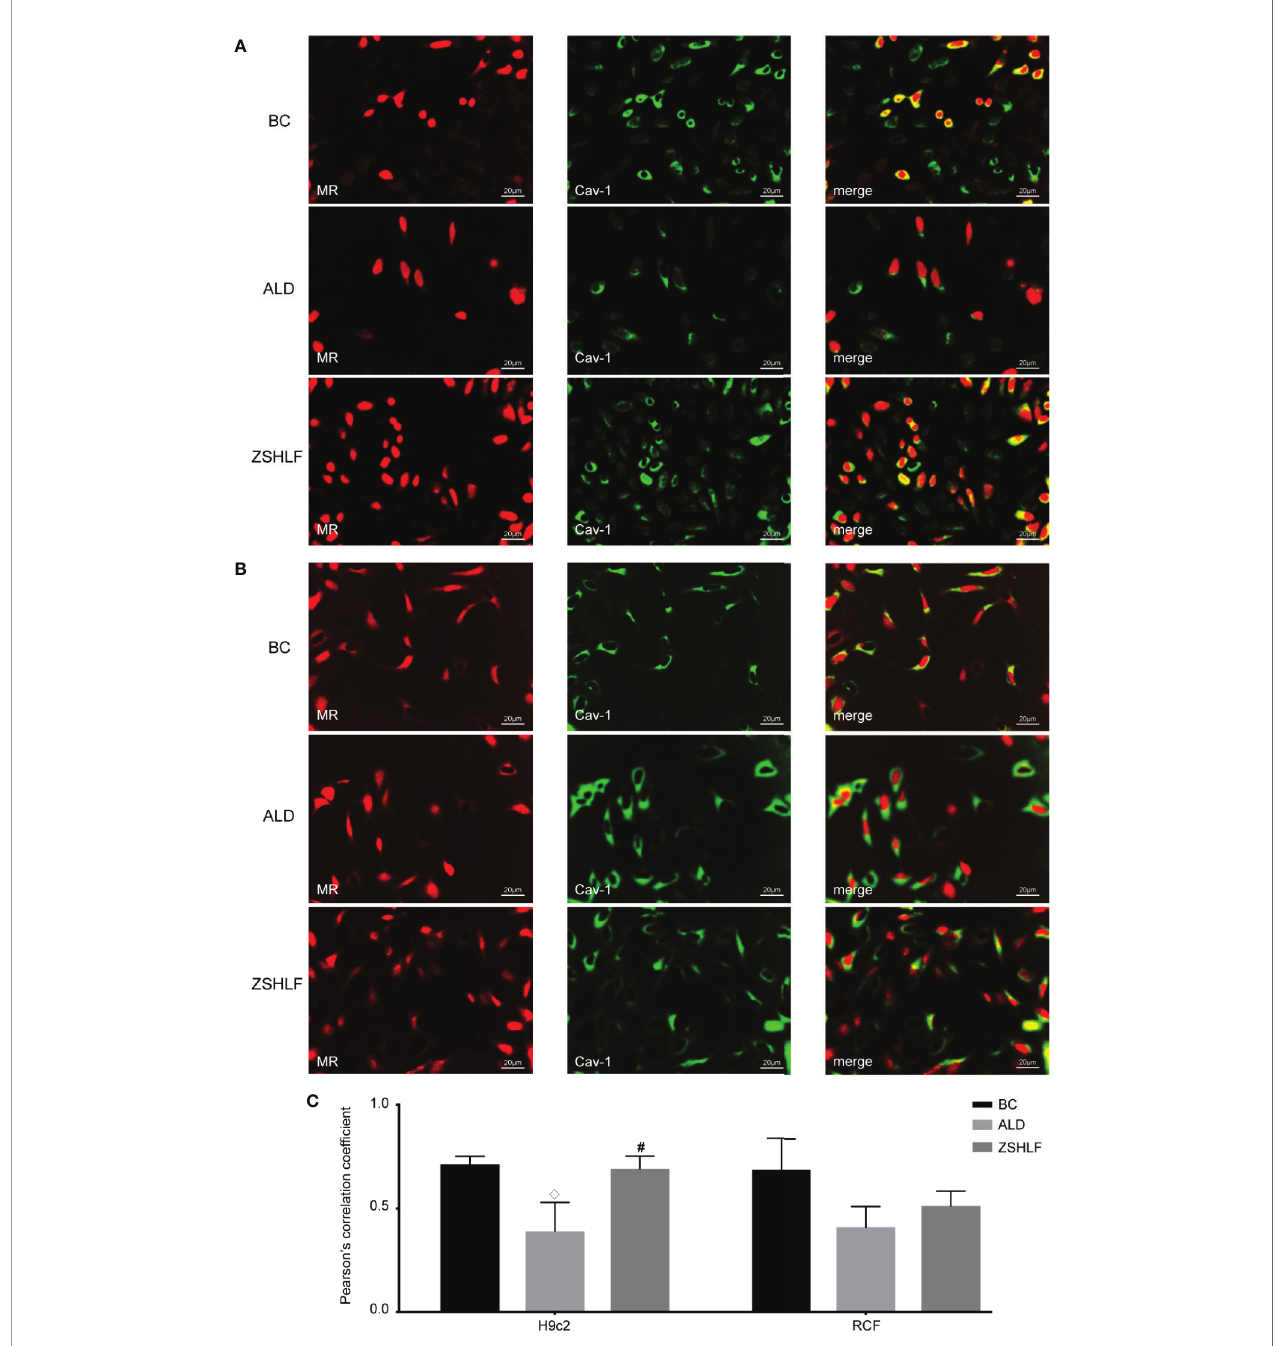
FIGURE 6 | Effects of Zi Shen Huo Luo Formula (ZSHLF) on caveolin-1 (Cav-1) and mineralocorticoid receptor (MR) colocalization in aldosterone (ALD)-induced H9c2 cells and rat cardiac fi broblasts (RCFs). (A) Immuno fl uorescence labeling of Cav-1 (green) and MR (red) in H9c2 cells. (B) Immuno fl uorescence labeling of Cav- 1 (green) and MR (red) in RCFs. (C) Effect of ZSHLF on Pearson ’ s r between Cav-1 and MR in H9c2 cells and RCFs. The data represent the mean ± standard deviation, n =3. # P < 0.05 vs. the BC group; ◇ P < 0.05 vs. the ALD